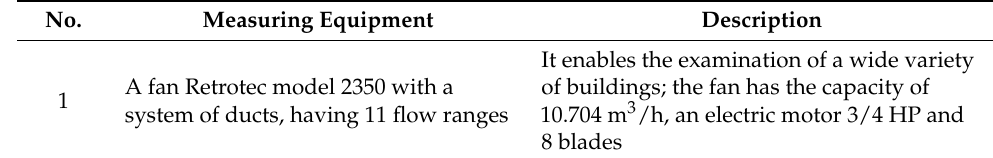
Table 7. Measuring equipment.